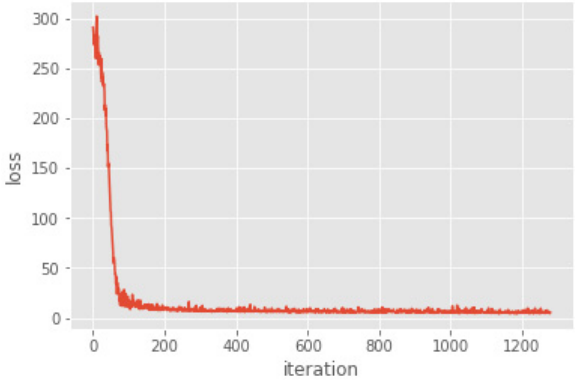
Figure 5. Reduction curve of the loss function. Table 3. Comparison of real and predicted values.